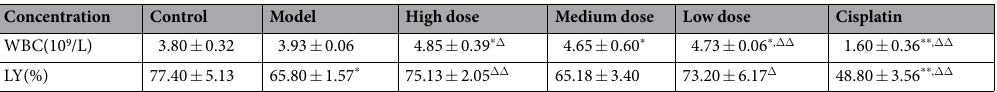
Table 3. Effect of GLE on blood WBC and LY of tumor-bearing mice. Note: * P < 0.05; ** P < 0.01, versus control values; Δ P < 0.05; ΔΔ P < 0.01, versus model